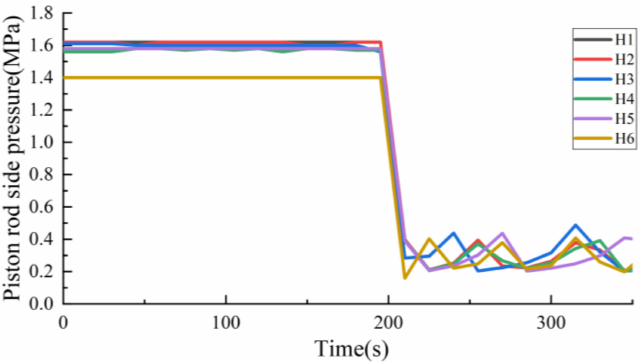
Figure 17. Piston rod side pressure of different leakage